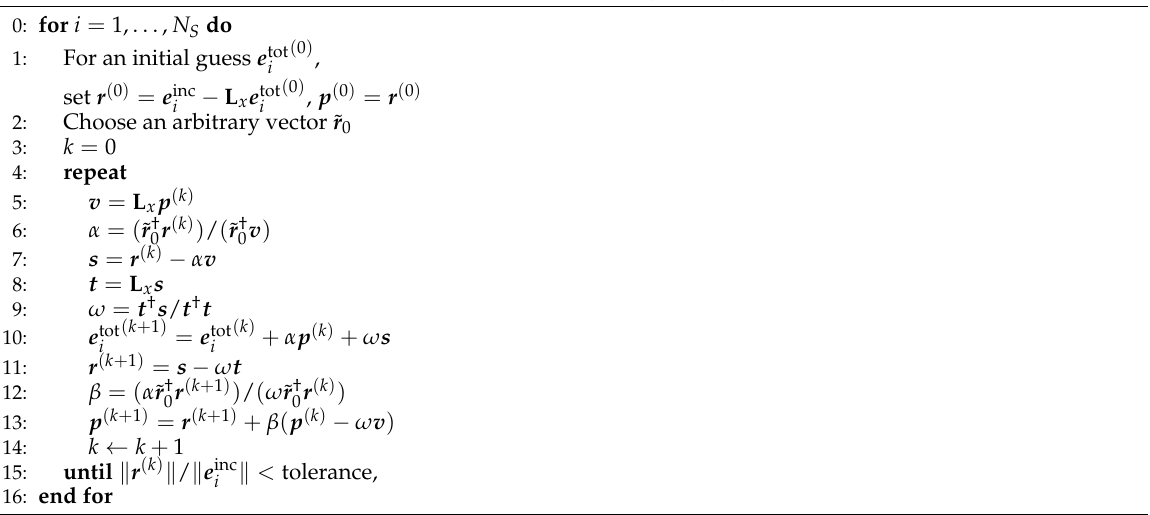
Algorithm 2 Sequential resolution of N S linear systems L x e tot